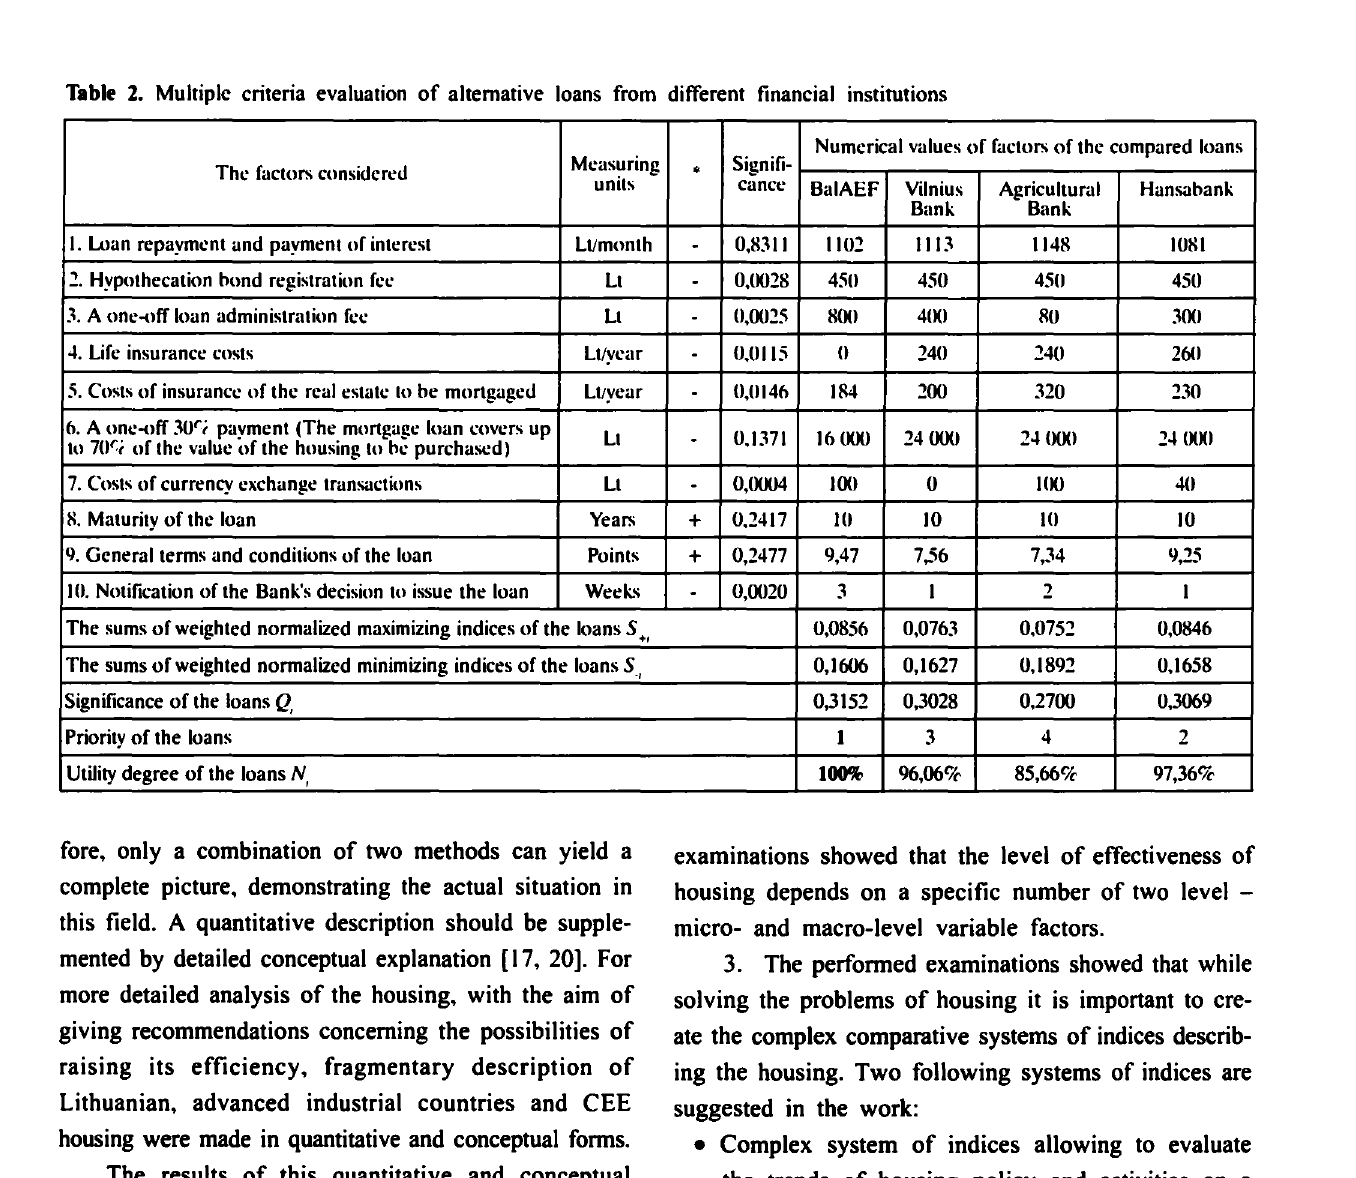
The ractors considered Measuring